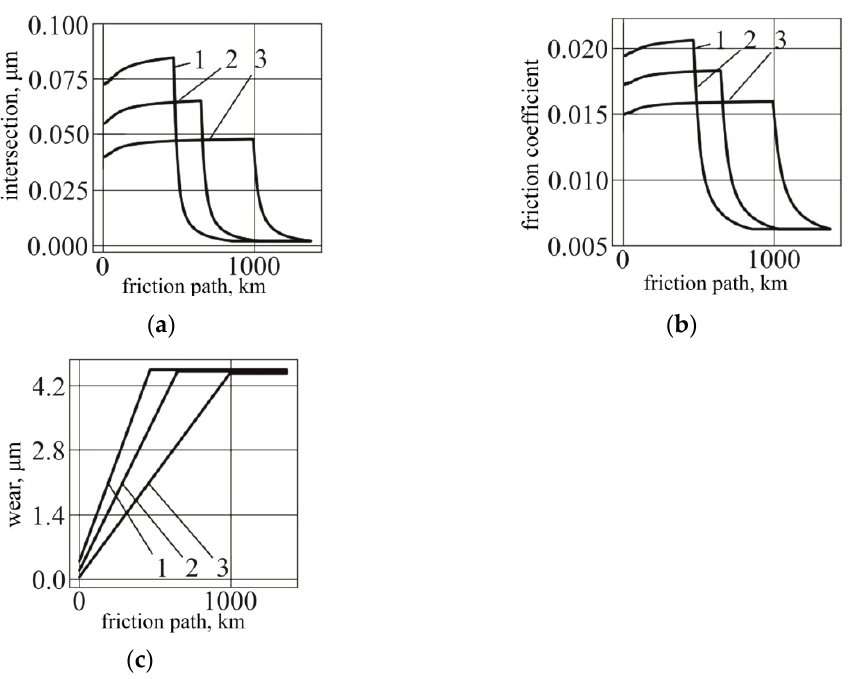
Figure 4. Friction characteristics ( a ) average contact intersection, ( b ) friction coefficient, ( c ) wear of half-bearing surface: 3—load 10 к N, 2—load 30 к N, 1—load 90 к N.